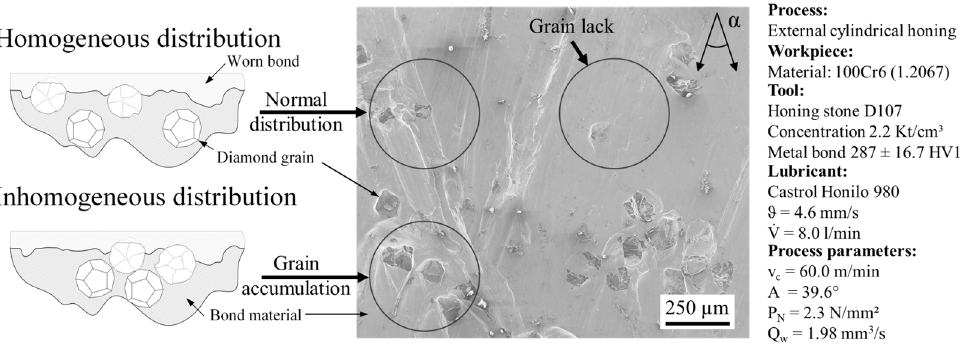
Figure 11. Schematic sketch for variations in grain distribution.